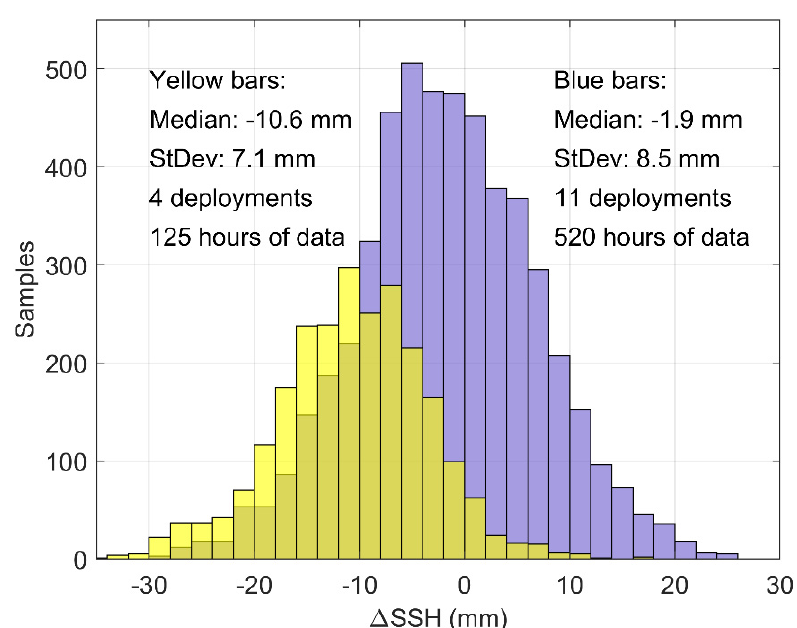
Figure 3. Histogram of δ SSH between both buoys deployed in close proximity at the Bass Strait Jason-series comparison point. StDev stands for standard deviation. A total number of 645-h 1 Hz GPS data was involved.